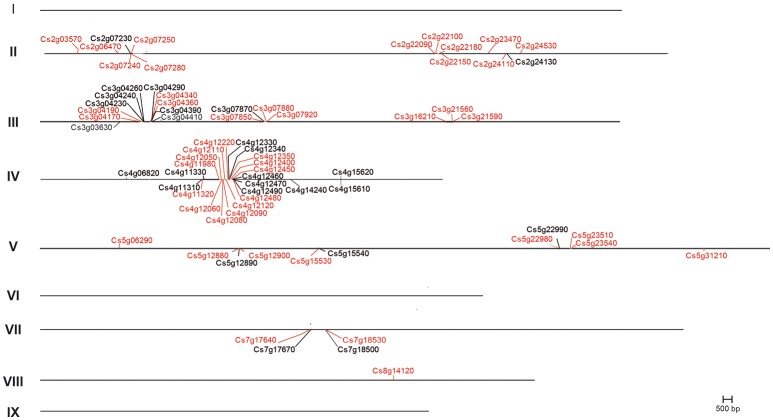
Graphic representation of chromosomic distribution of citrus TPS gene models in the sweet orange genome. Genes whose names begin with Cs2g, Cs3g, Cs4g, Cs5g, Cs7g, and Cs8g are located on chromosomes 2, 3, 4, 5, 7, and 8 respectively. In chromosomes 1, 6, and 9 it is not predicted the localization of any TPS. Twenty four genes could not be localized to a specific chromosome. Red letters represent putative complete TPS genes, black letters represent putative TPS pseudogenes. Letters over/down the lines representing chromosomes correspond to those genes predicted in the ± strands, respectively. The exact position of each gene is indicated in Supplementary Table 3.